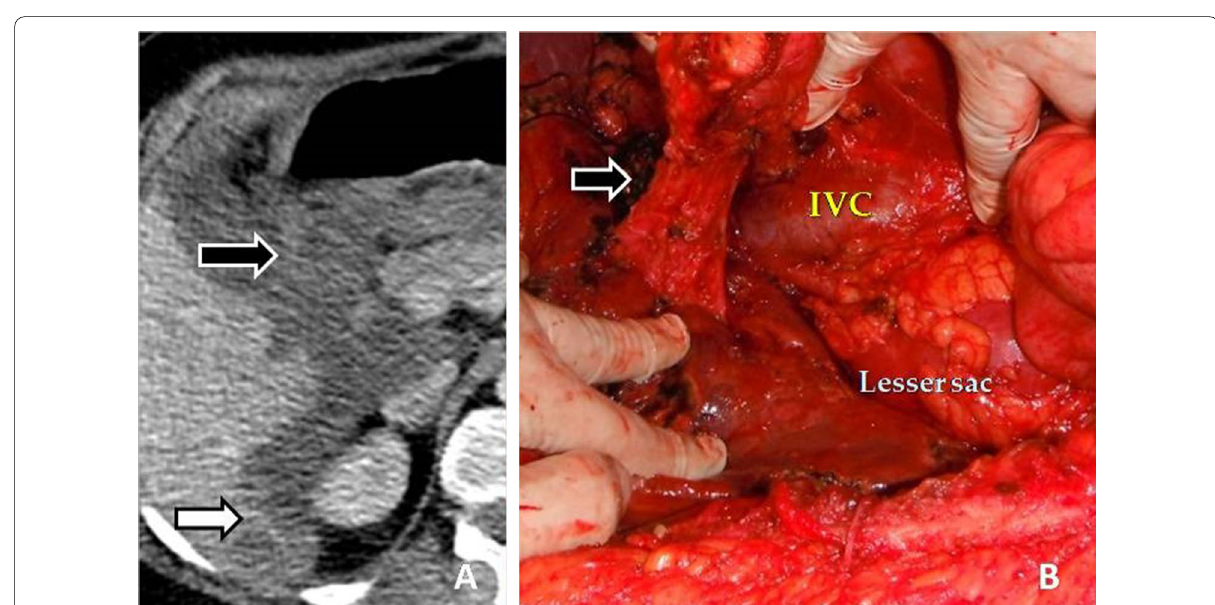
Fig. 3 a Ε nhanced CT image of a patient with peritoneal carcinomatosis demonstrates extensive infiltration of the hepatoduodenal ligament (black arrow) and implants in the Morrison pouch (white arrow). b At surgery, malignant implants are demonstrated at the hepatoduodenal ligament (arrow). Inferior vena cava (IVC) and lesser sac are also